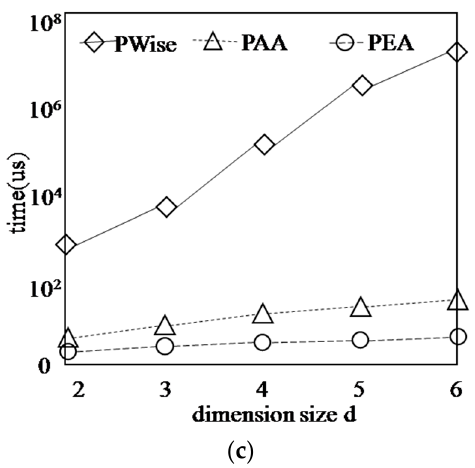
Figure 15. Finding G-Skyline with different dimension size d. ( a ) COR; ( b ) IND; ( c ) ANTI-COR.